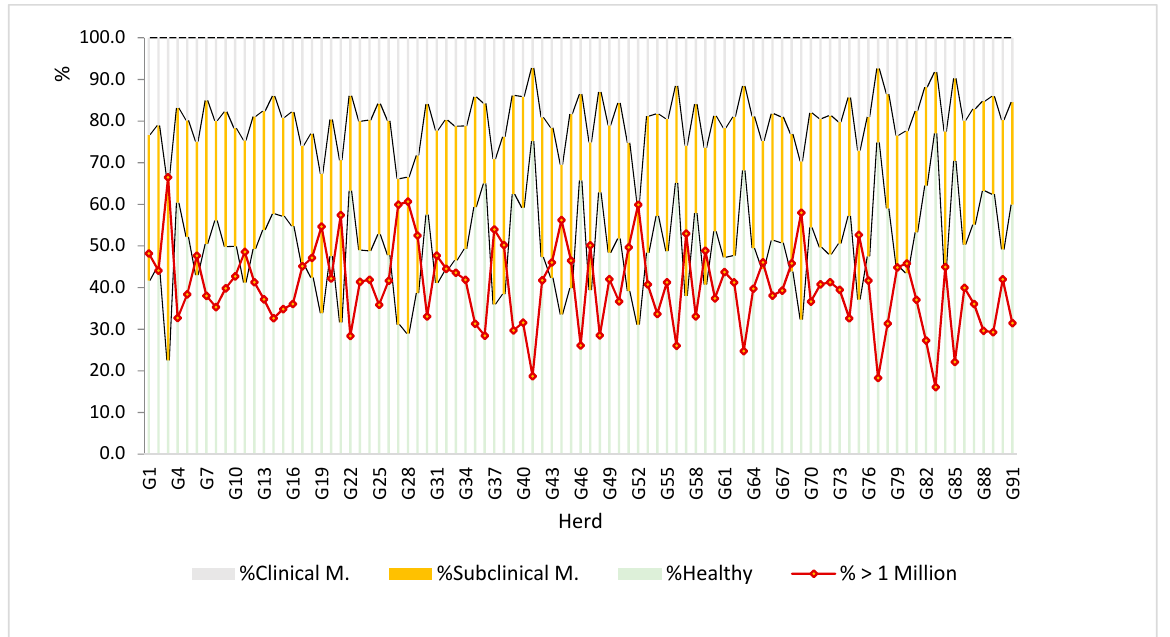
Figure 2. Estimation of presence (subclinical and clinical) or absence of mastitis, based on the Paape et al. 2001 criteria (healthy/>1 million suspected of mastitis) and Renée de Crémoux, 2012 (healthy, subclinical, or clinical mastitis) in each of the Florida breed farms in the study.